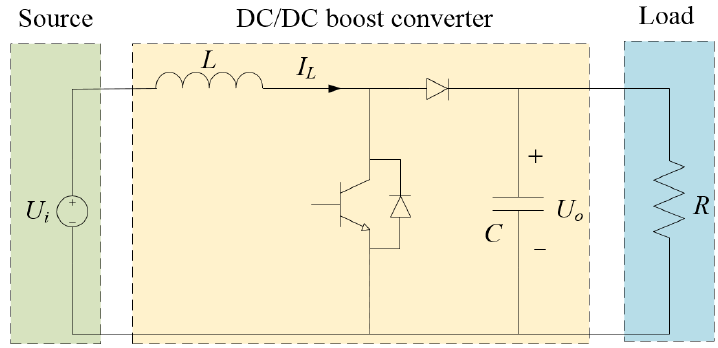
/ DC boost converter Figure 1. DC/DC boost converter circuit . Figure 1. DC